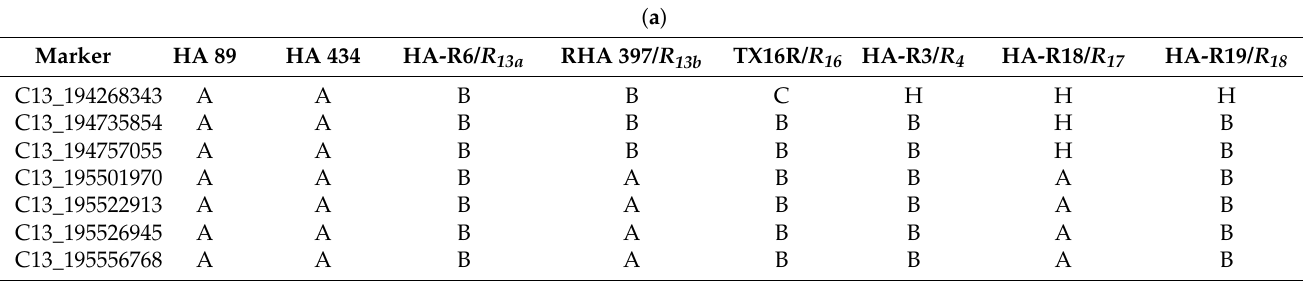
A represents HA 89 marker allele; B represent HA-R6 marker allele; C represents the marker allele different A and B, H represents